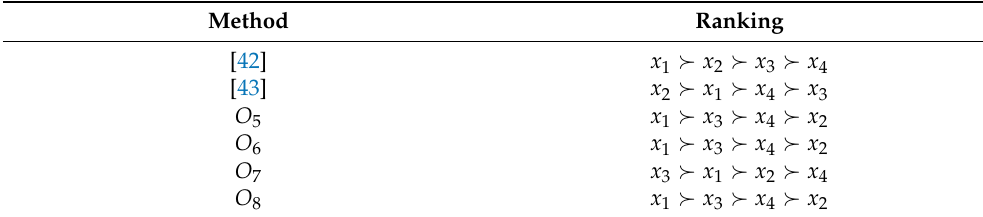
Table 8. Summary of the rankings obtained from the proposed method and the method in